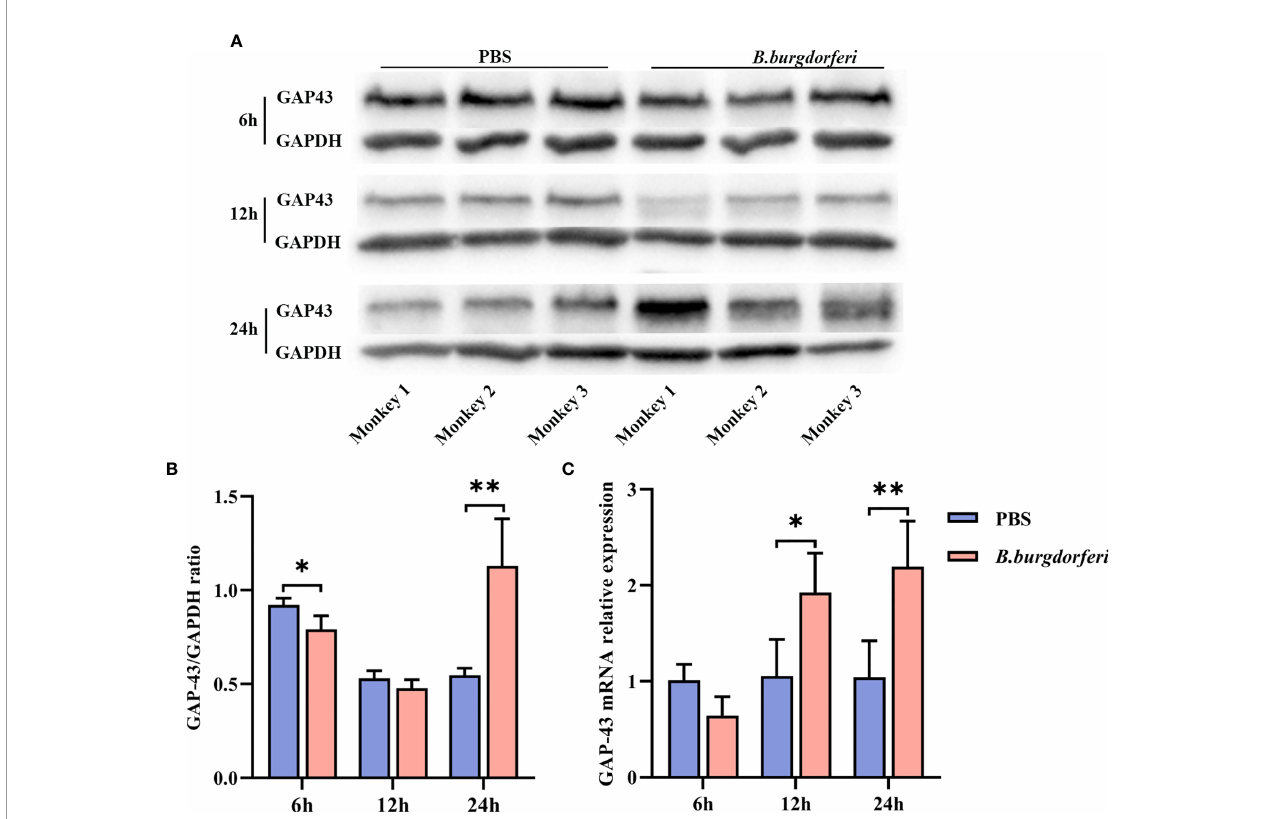
FIGURE 3 | Signi fi cant alteration of GAP-43 mRNA and protein levels in explants from the frontal cortex of rhesus macaque brains at different time points after Bb treatment. (A) Protein expression of GAP-43 in explants from the frontal cortex of rhesus macaque brains co-cultured with live Bb and the controls at 6, 12, and 24 h, validated by western blotting. (B) Quantitative analysis of GAP-43 protein expression levels. (C) qPCR analysis of GAP-43 mRNA expression comparing explants from the frontal cortex of rhesus macaque brains co-cultured with live Bb with the controls at 6, 12, and 24 h. ** P < 0.01, * P < 0.05. Analyzed with two-way ANOVA and data were expressed as the means ±